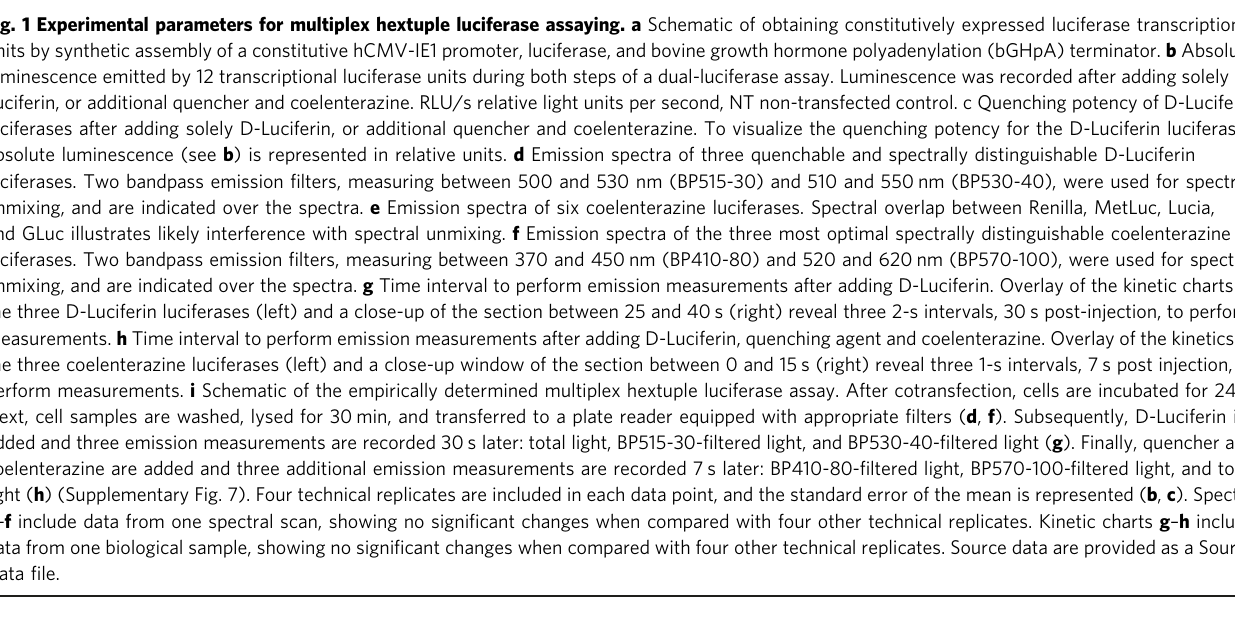
Fig. 8b, left). The RedF luciferase signal was constant in all the samples, and the slope of this regression did not signi fi cantly differ from zero as expected. We performed a similar experi- mental setup for the two other combinations, resulting in similar quality regression lines when FLuc and RedF were varied and ELuc was kept constant ( r 2 FLuc = 0.9906 and r 2 RedF = 0.9993) (Fig. 2c and Supplementary Fig. 8c, left), as well as when ELuc and RedF were varied and FLuc was kept constant ( r 2 ELuc = 0.9979 and r 2 RedF = 0.9979) (Fig. 2d and Supplementary Fig. 8d,